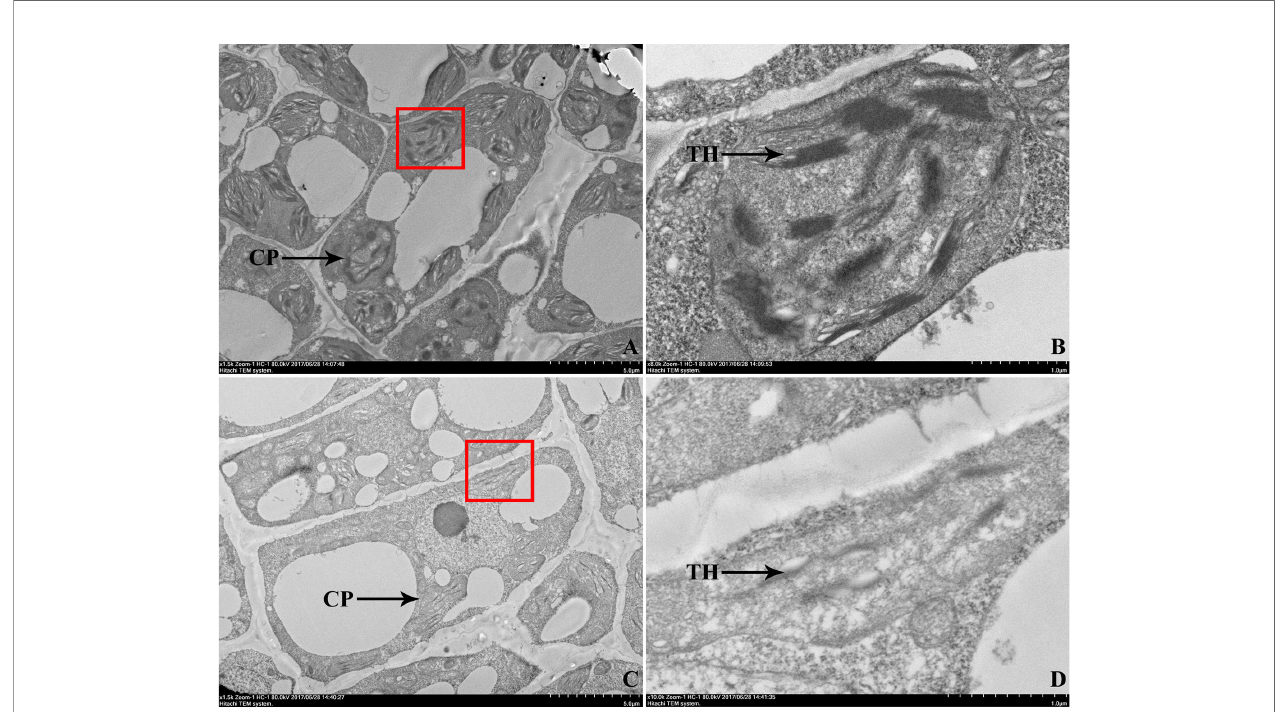
FIGURE 3 | Transmission electron microscopic observation of the fi rst true leaves in EC1 and 104Y. (A, B) Transmission electron microscopy of the chloroplast ultrastructure of EC1 leaf, (B) was a larger version of the red box in (A) . (C, D) Transmission electron microscopy of the chloroplast ultrastructure of 104Y leaf, (D) was a larger version of the red box in (C) . CP was the abbreviation of chloroplast. TH was the abbreviation of thylakoid.